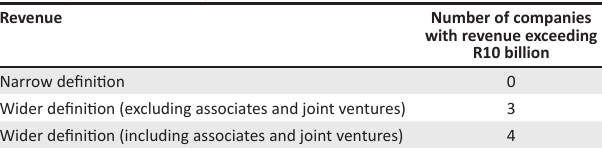
TABLE 3: Comparison of alternative revenue definitions for companies with a revenue (narrow definition) more than R8 billion, but less than R10 billion. Revenue